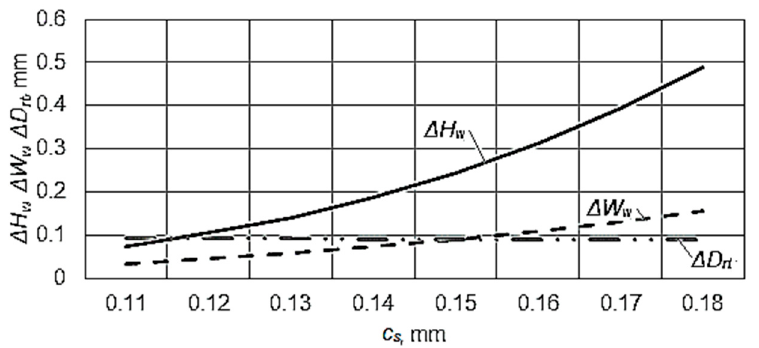
Figure 7. Influence exerted by the side clearance c s on the deviations Δ H w , Δ W w , and Δ D rt ( t w = 4 mm, l s = 6.5 mm, c a = 0.54 mm).